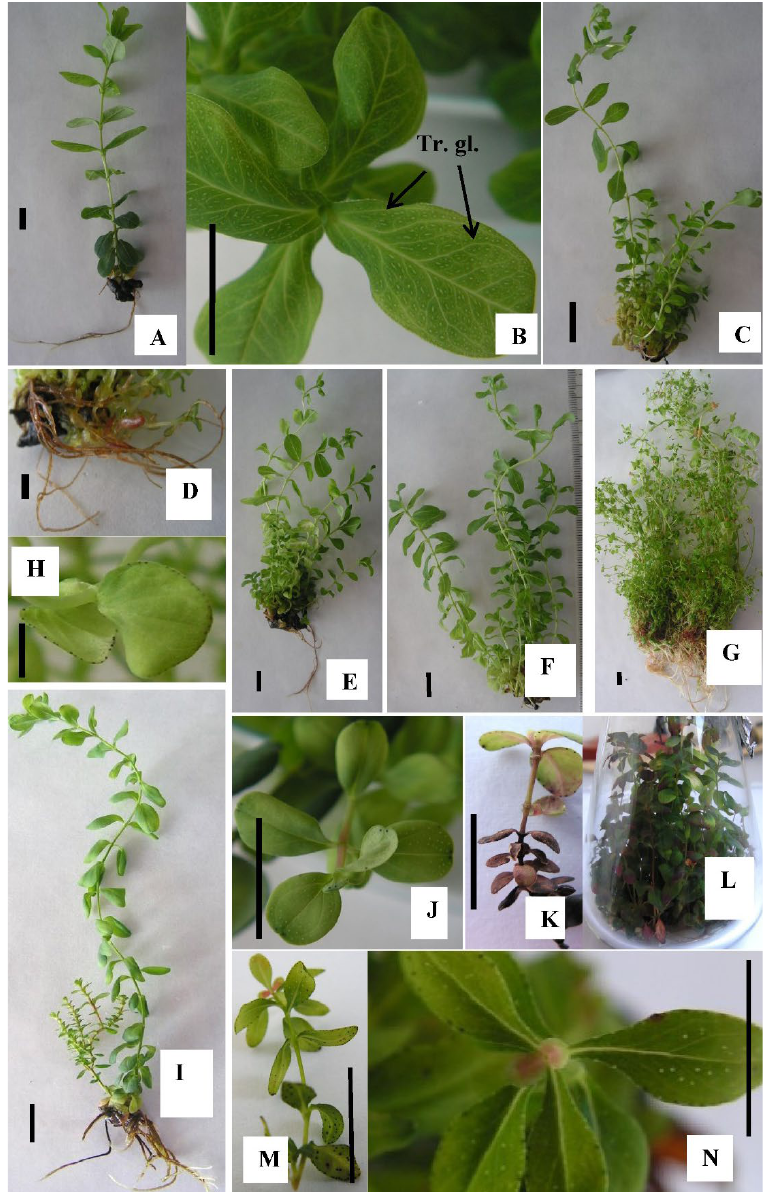
Figure 2. In vitro cultivated shoot cultures of H. calycinum L. in M_0 culture medium ( A ) with well visible translucent glands (Tr. gl.) on the leaves ( B ); stimulation of axillary shoot formation ( C ) and rooting ( D ) in M_1 medium; stimulation of the height of auxillary shoots formed in M_2 medium ( E ); further stimulation of the height of axillary shoots and inhibition of rooting in M_3 medium ( F ); intensive biomass formation ( G ) and dark glands on leaves margins ( H ) in in PGR-free M_0 medium H. tetrapterum Fries.; biomass formation ( I ) and dark and translucent glands on leaves ( J ) in H. perforatum L. in M_0 medium; growth inhibition and necrosis in PGR-free M_0 medium in H. richeri Vill. ( K ); biomass formation stimulation H. richeri Vill. ( L ) with well visible translucent and dark glands on the leaves ( M , N ) in M_2 medium. Space bar = 1 cm .